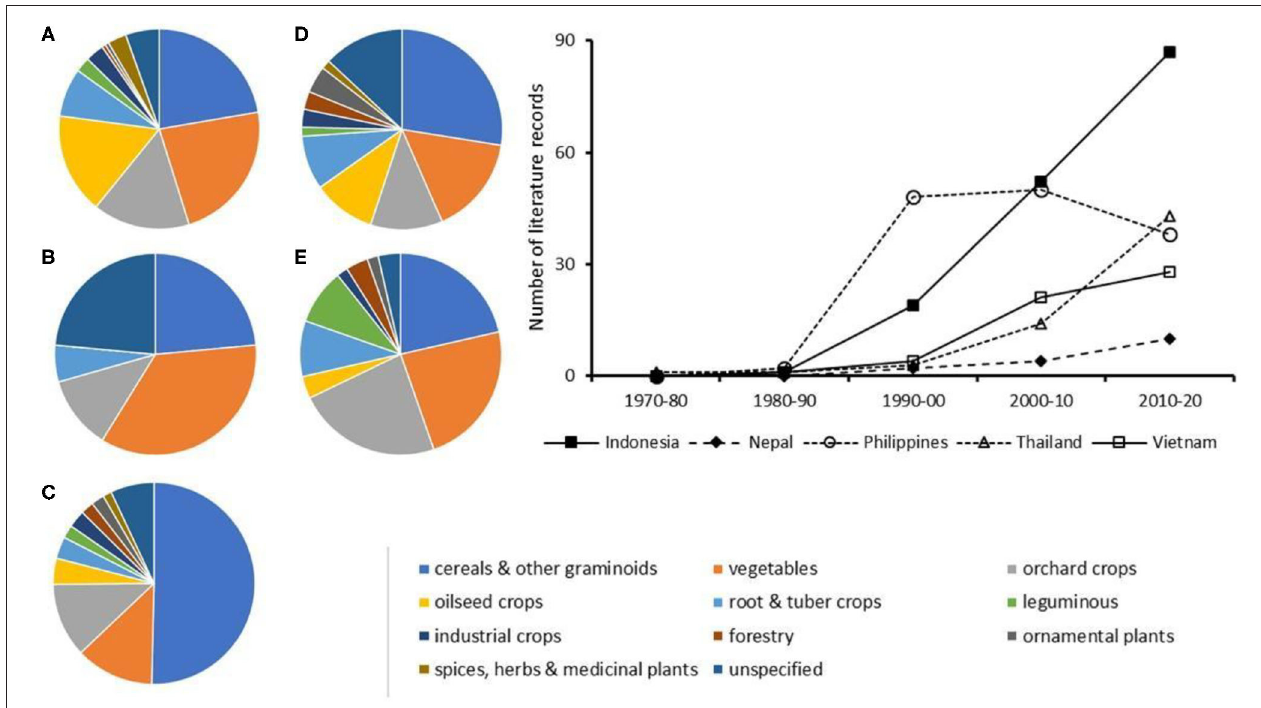
FIGURE 1 | Temporal and commodity-specific trends in biological control science for selected Asia countries, as determined through systematic literature searches. The left panel comprises pie charts that reflect the relative scientific attention to different classes of agricultural commodities for Indonesia (A) , Nepal (B) , Philippines (C) , Thailand (D) , and Vietnam (E) . The right panel depicts interdecadal trends in the number of scientific publications covering biological control, for each of the above countries. Crop classifications are based on the United Nations Food and Agriculture Organization, UN-FAO.